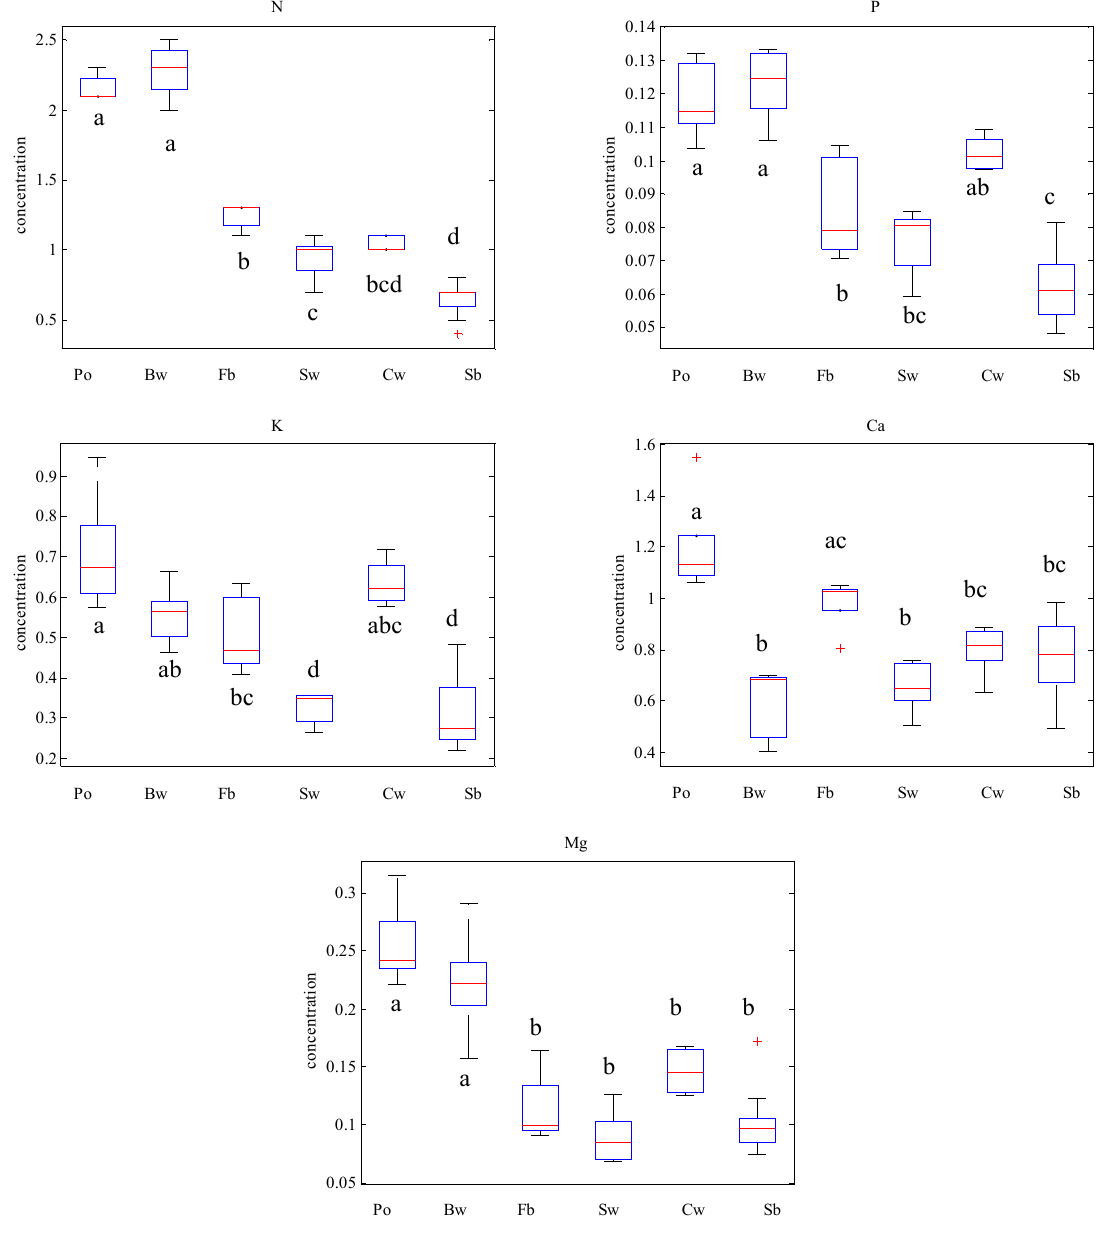
Figure 2. Boxplots of foliar macronutrient concentration: Units of concentration are %. n = 5 for all species except black spruce ( n = 13). Lowercase letters denote significant differences in macronutrient concentration among species ( p ≤ 0.05). Po = trembling aspen; Bw = white birch; Fb = balsam fir; Sw = white spruce; Cw = white cedar; and Sb = black